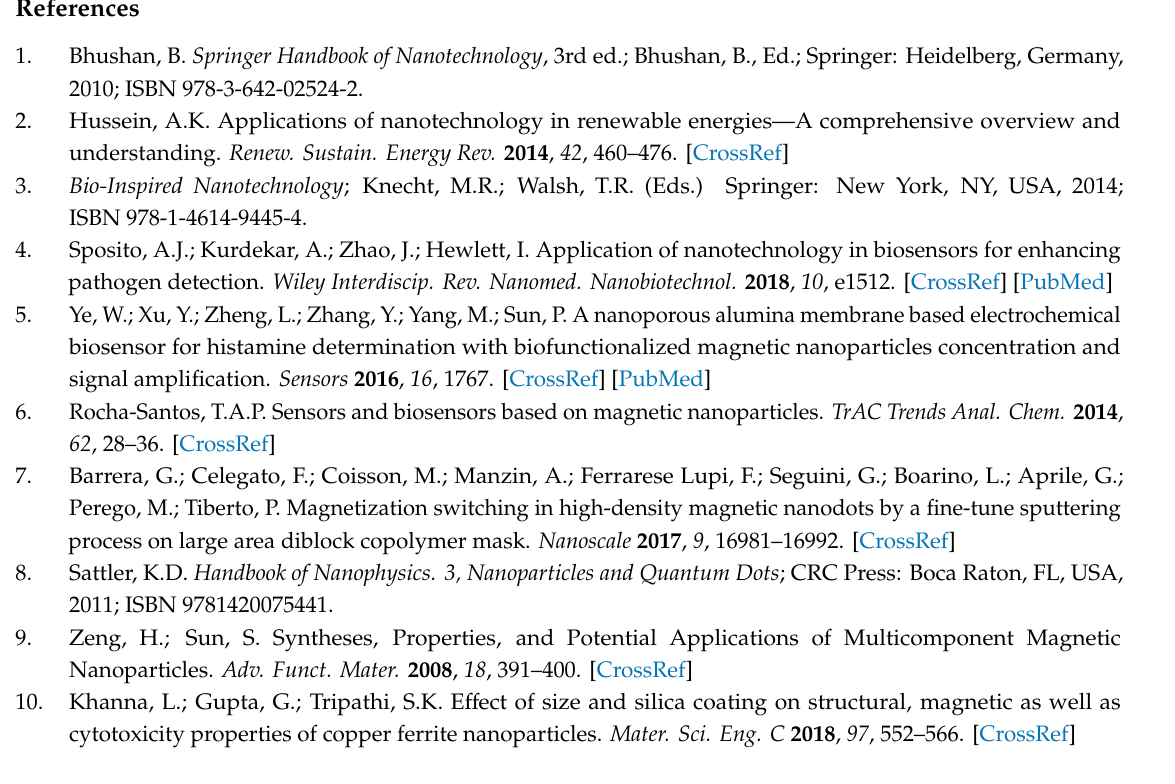
Figure S1: A selection of the ac-hysteresis loops acquired at the selected vertex fields for all samples. Author Contributions: Conceptualization, P.T. (Paola Tiberto), M.C. F.M. and S.N.K.; preparation of the samples, P.T. (Priyanka Tiwari) and R.V.; XRD characterization and structural data analysis, P.T. (Priyanka Tiwari), R.V. and S.N.K.; DC-magnetic measurements and data analysis, G.B., M.C., F.C. and F.M.; AC-magnetic measurements